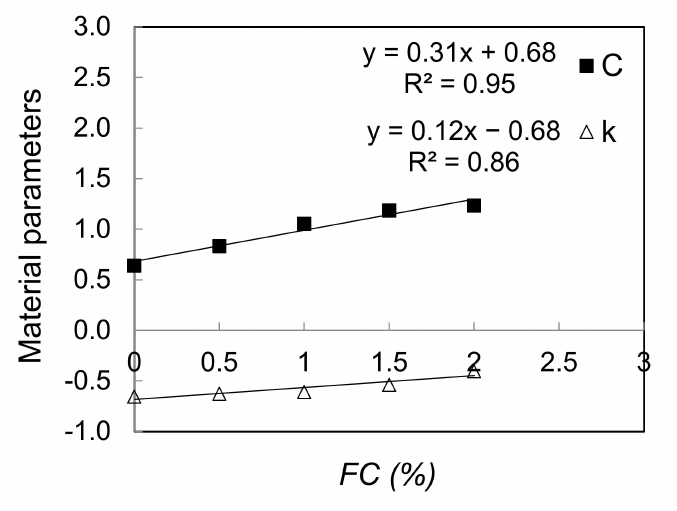
Figure 11. The effect of fiber content on material damping parameters C and k